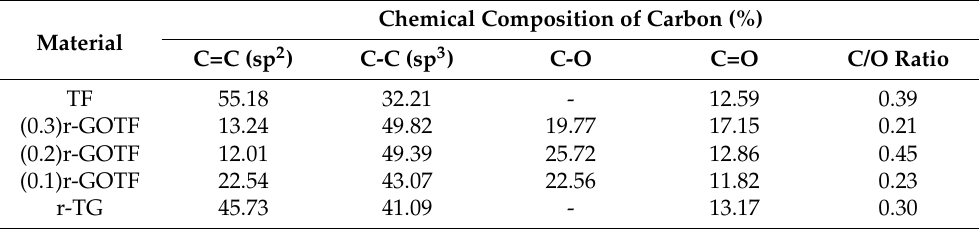
Table 1. Surface atomic composition of synthesized nanocomposites.